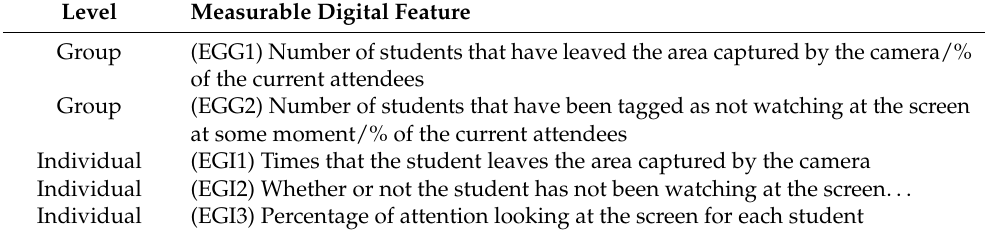
Table 16. Set of digital features defined for “eye gaze” category, corresponding to features E6, E5 and E8.